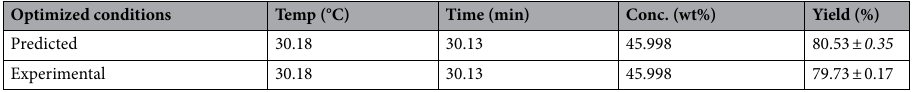
Table 5. Result of experimental check of the predicted yield at optimal conditions.